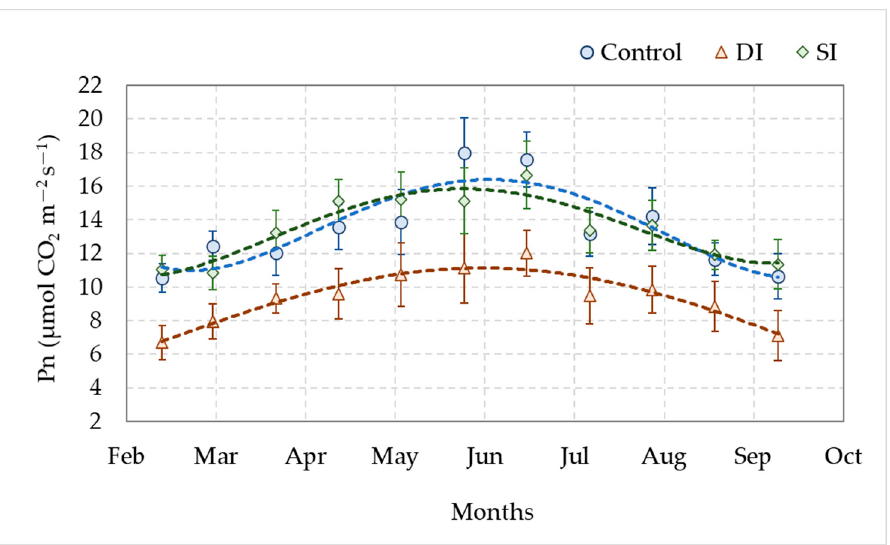
Figure 8. Effect of drip irrigation (DI), subsurface irrigation (SI), and bubbler irrigation (control) systems on photosynthesis (Pn) of date palm (Khalas cv.). Each data point for SI and DI systems represents an average of 50, 75, and 100% ETc levels, whereas it is at 100% ETc level for control during 2020–2021.